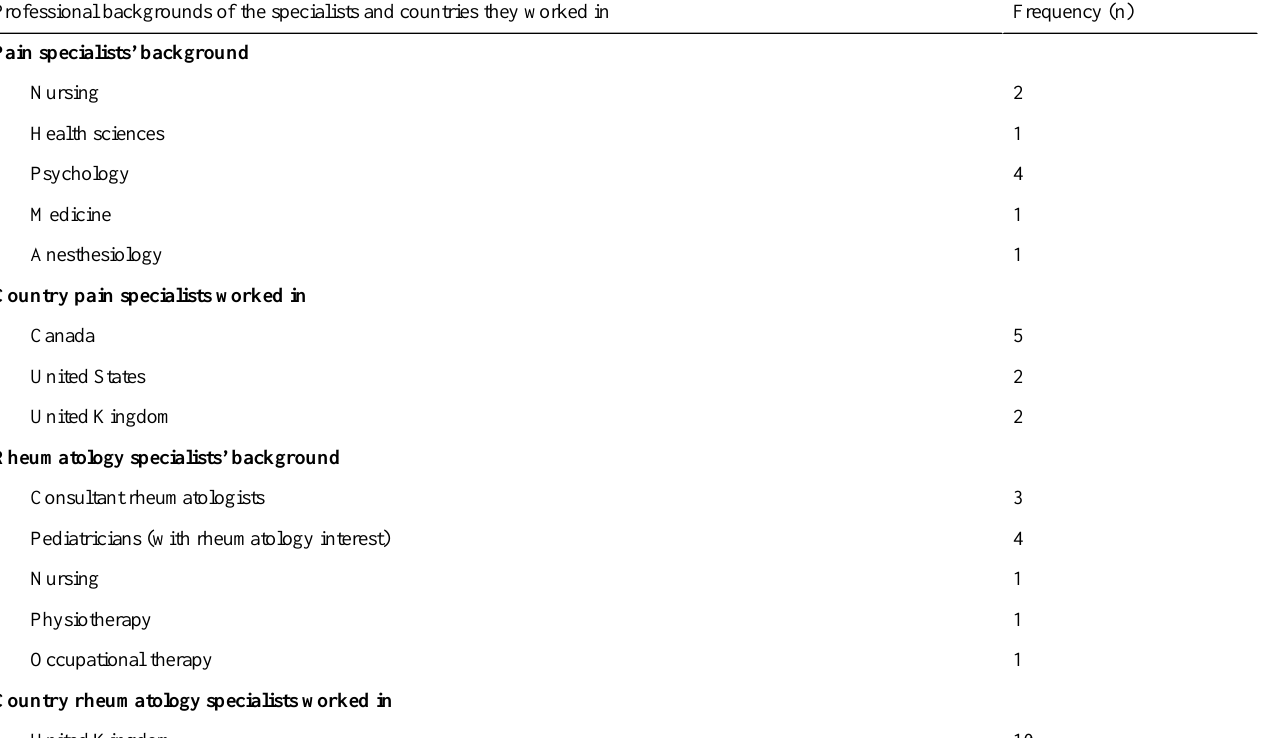
Frequency (n)Professional backgrounds of the specialists and countries they worked